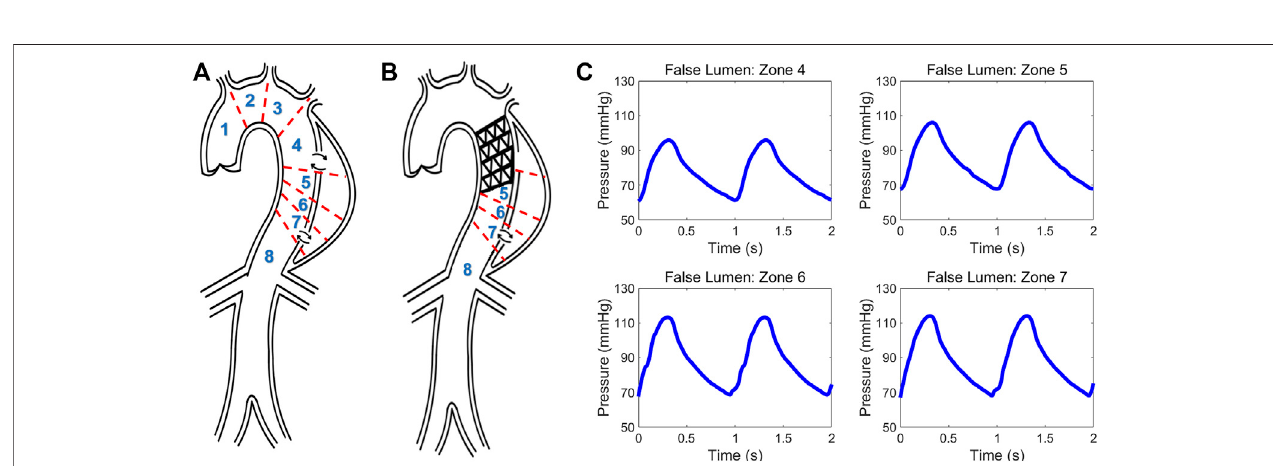
FIGURE 5 | Schematic of type B aortic dissection (A) pre- and (B) post-TEVAR. Different zones are classi fi ed for computing hemodynamic quantities. (C) Invasive pressure data measured post-TEVAR via the ComboMap system from the patient.